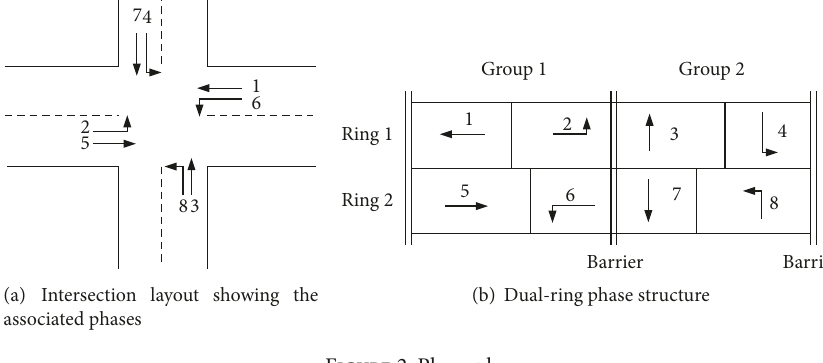
Figure 2: Phase plan.